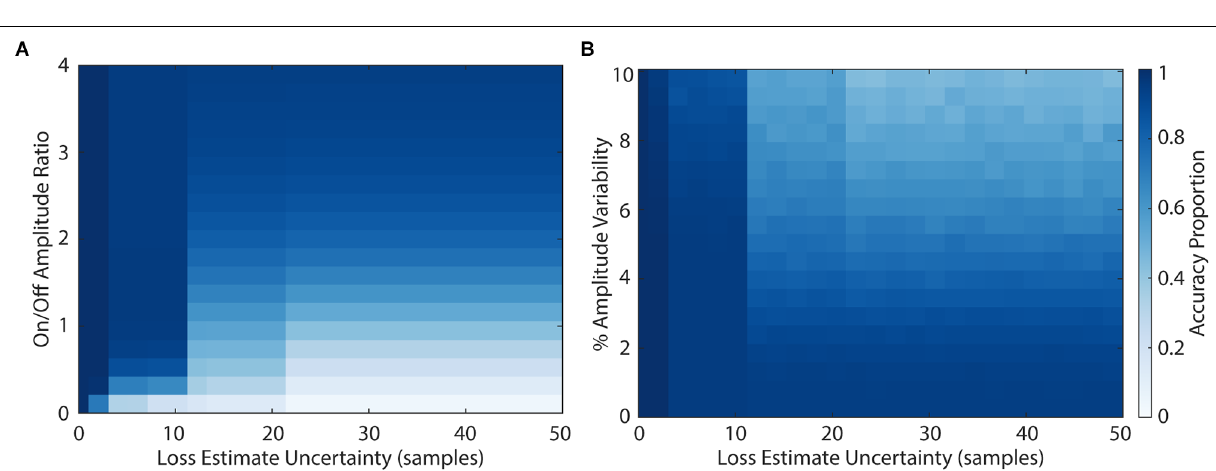
FIGURE 5 | Accuracy of loss estimation as a function of amplitude ratio, amplitude variability, and uncertainty. The accuracy of loss estimation was computed for 100 simulated trials with 20% of the packets removed. More accurate parameter combinations are indicated by darker values in the colormap. Amplitude ratios (A) ranged from 0 to 4, amplitude variability (B) ranged from 0% to 10%, and uncertainty ranged from 0 to 50